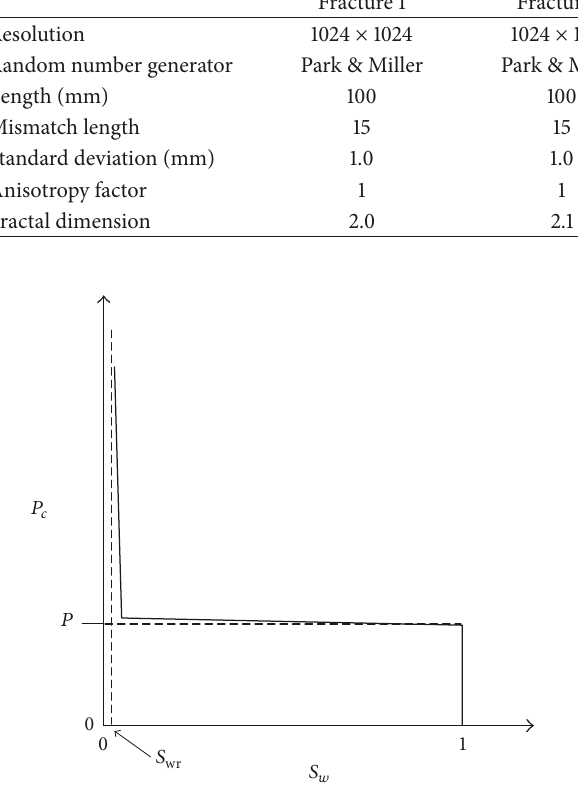
Figure 2: Capillary pressure-saturation relationship at the local position in a single fracture ( 𝑆 𝑤 is water saturation and 𝑆 wr the residual wetting phase saturation) [10,